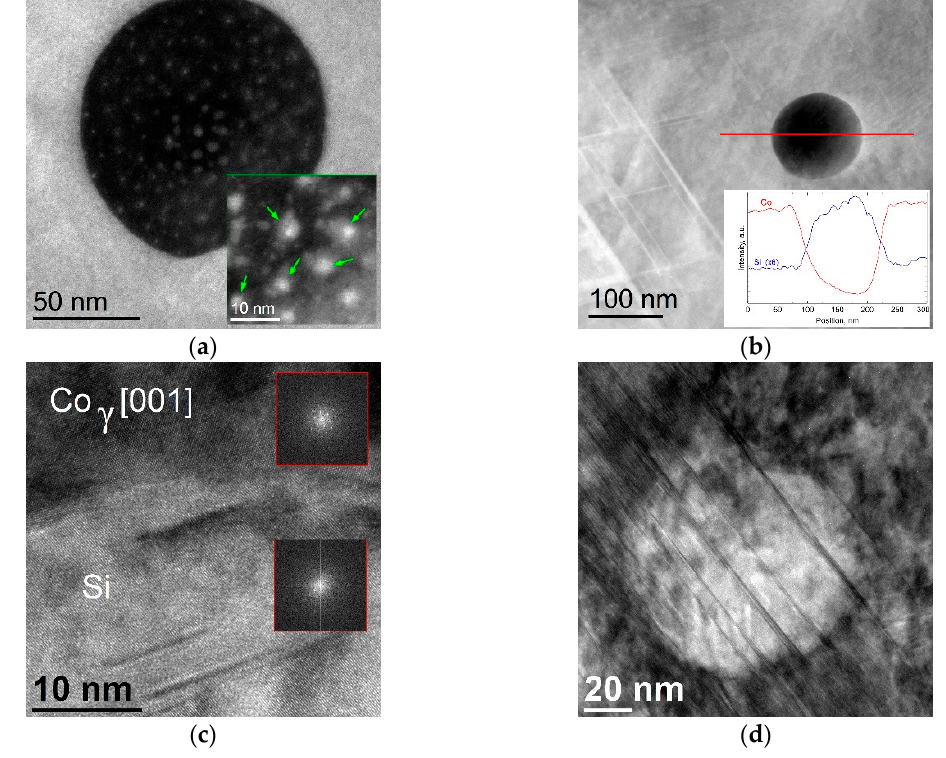
( c ) Figure 10. TEM image of selected precipitate in the Co-PIM sample ( a ). SAED electron diffraction of σ phase (Co 7 Cr 8 ) in [120] the direction ( b ). Model of Co 7 Cr 8 unit cell ( c ). 3.2. Wear Resistance of Co-SLS and Co-PIM Figure 11 shows a comparison of friction coefficient changes during ball-on-disk wear testing for the Co-SLS and Co-PIM samples. The friction coefficient of the Co-SLS sample remained constant (approximately 0.4) throughout the measurement. In the first part of the test (up to 60 m), the friction coefficient of the PIM sample was about 0.6, and then increased to 0.8. The worn surfaces were then